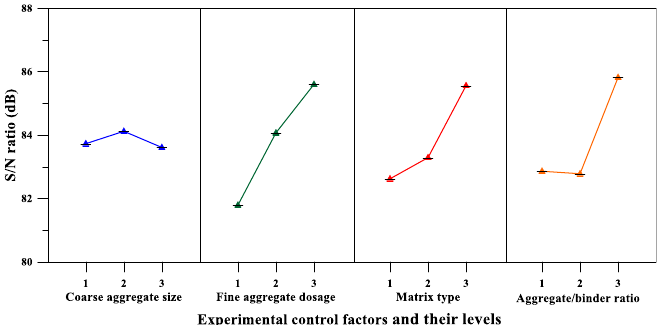
Figure 11. S / N response graph showing the elastic modulus of pervious concretes.